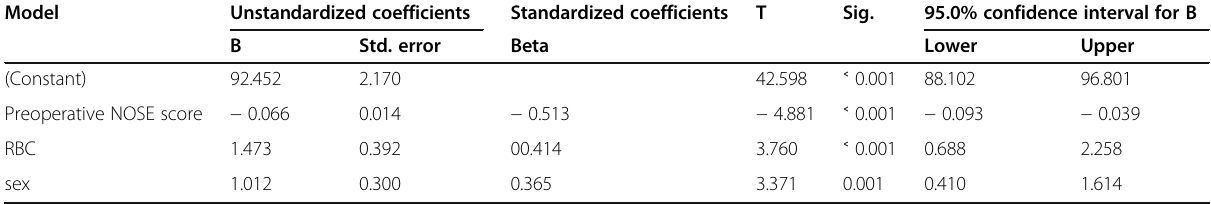
Table 5 Multiple linear regression model of factors affecting SPO2